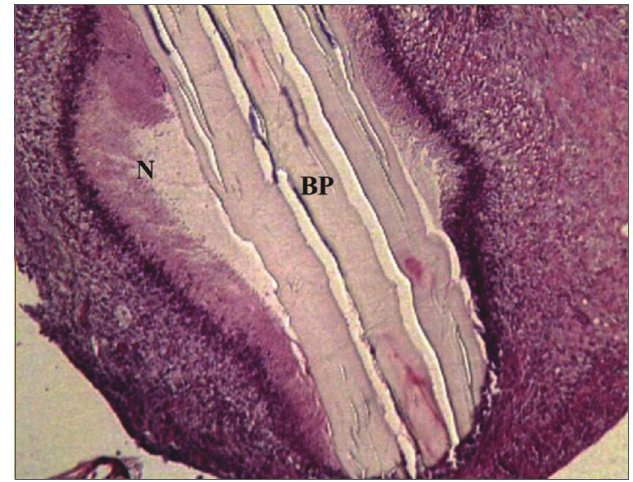
Figura 3. Grupo experimental com 12 semanas - Fotomicrografia da membrana do biopolímero da cana-de-açúcar na bula timpânica sem sinais de reação inflamatória. OT= osso temporal; seta larga= biopolímero da cana-de-açúcar. HE(aumento de 40x).